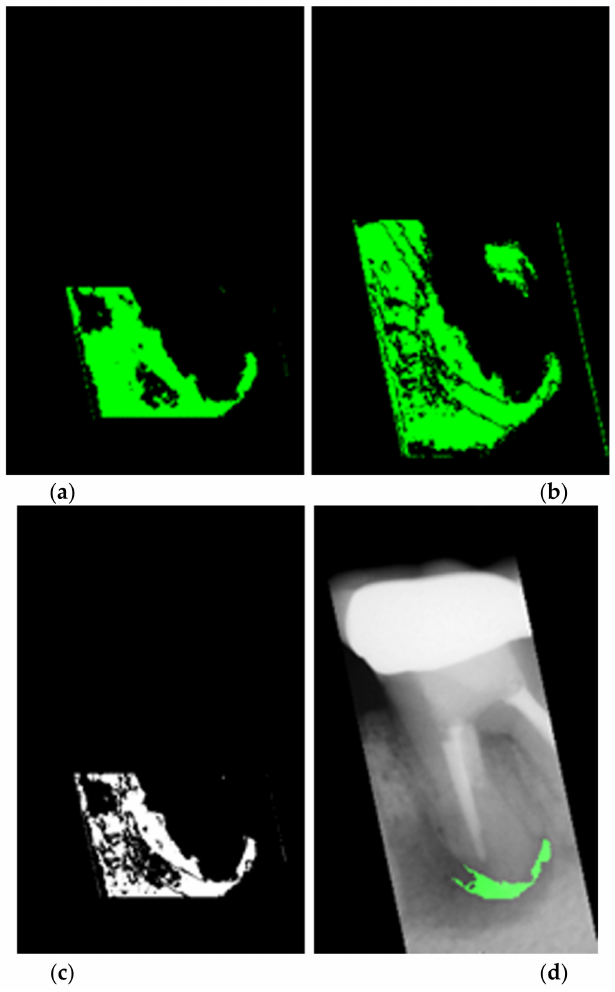
Figure 7. The image in different computing methods. ( a ) computed average image, ( b ) calculated pixel value difference for every pixel to the upper pixels and to the lower pixels, ( c ) superimposed image after going through the previous methods, ( d ) the final preprocessed image.